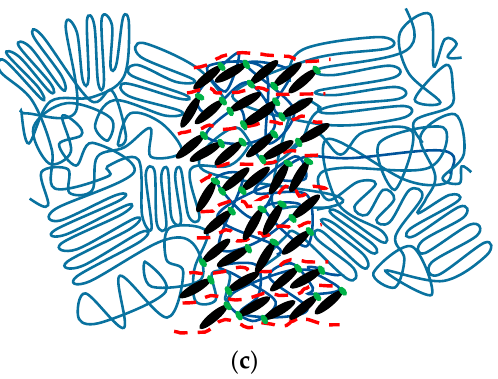
Figure 11. Phase behavior of Azo/PEG complexes: ( a ) Azo, ( b ) Azo/PEG before crystallization, and ( c ) Azo/PEG after crystallization.